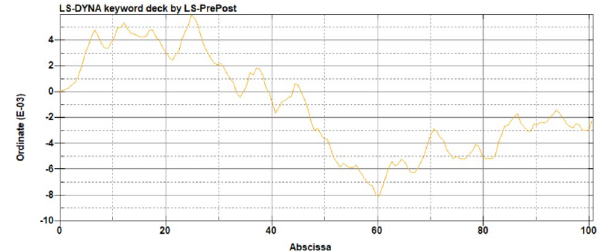
Figure 3. The irregularity of the track.